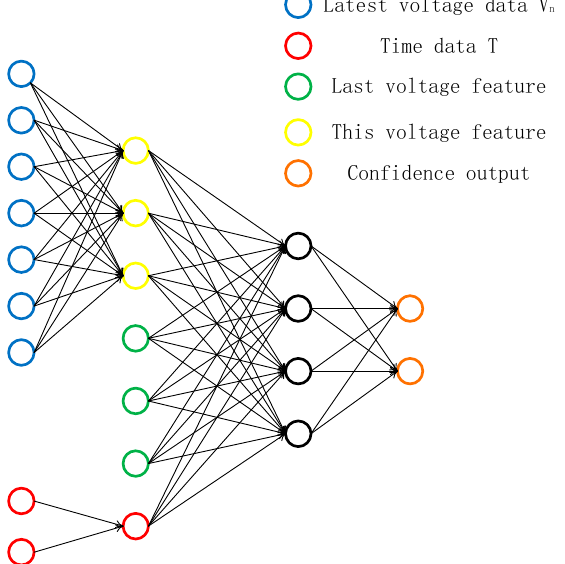
Figure 5. The node calculation diagram of the actual application of the data dimensionality reduction model and the logistics classifier.